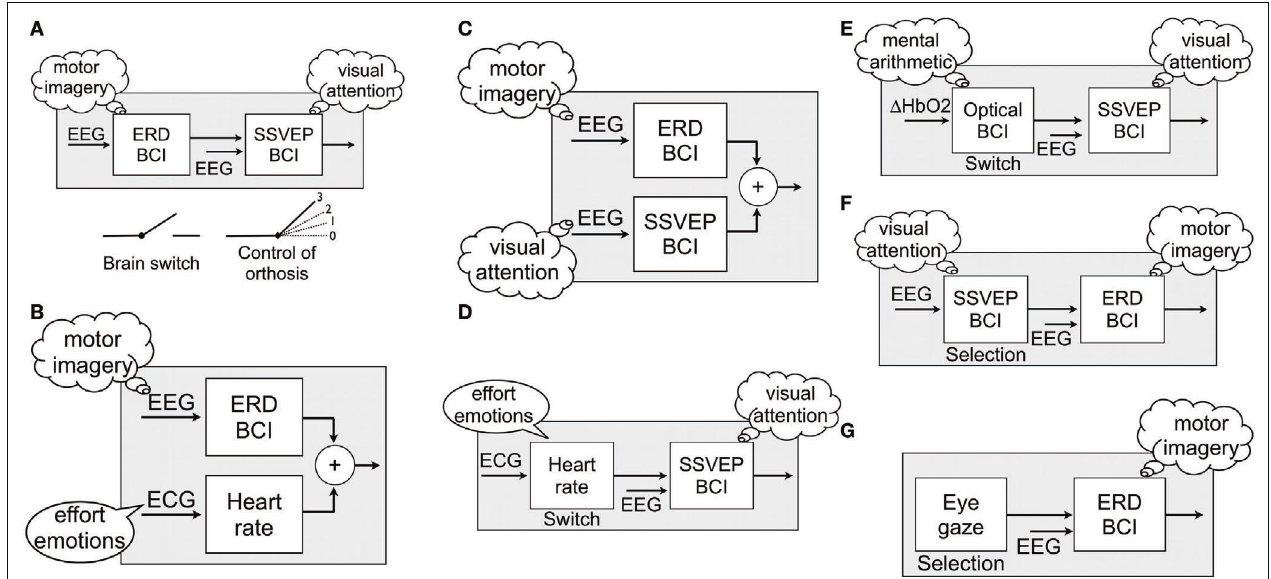
FIGURE 1 | Examples of hybrid BCIs with sequential (A,D–G) and simultaneous processing